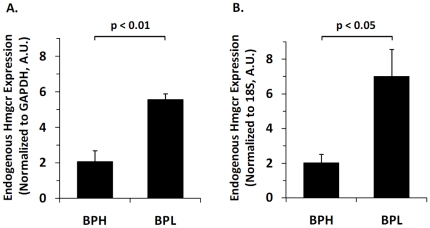
Endogenous Hmgcr expression in BPH and BPL liver tissues.Total RNA was extracted from liver tissues of BPH (n = 4) and BPL (n = 4) mice and total cDNA was synthesized. Real-time PCR using the cDNA preparations were carried out with mouse Hmgcr specific primers as described in the Materials and Methods. The Hmgcr mRNA levels among the samples were normalized by GAPDH (panel A) and 18S rRNA (panel B). The Hmgcr mRNA abundance in BPL was significantly higher than BPH.